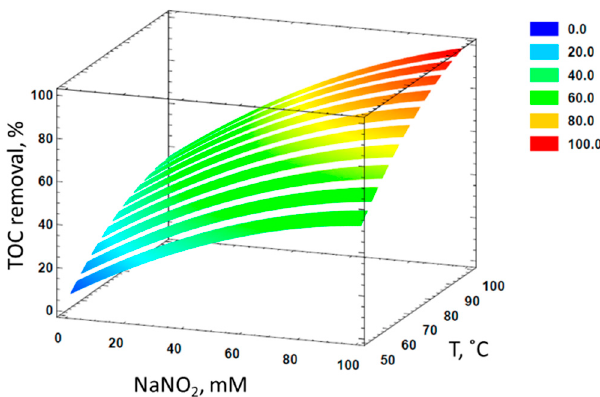
Figure 5. Response surfaces to assess the e ff ect of both dose of NaNO 2 and temperature on TOC Figure 5 . Response surfaces to assess the effect of both dose of NaNO 2 and temperature on TOC removal after 30 min of treatment at a fixed dose of HNO 3 of 1.72 M. removal after 30 min of treatment at a fixed dose of HNO 3 of 1.72 M.